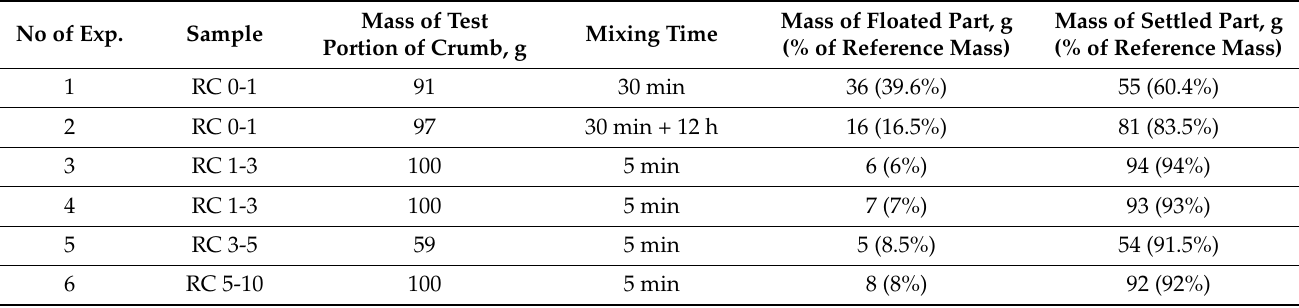
Table 1. Results of wettability tests for rubber